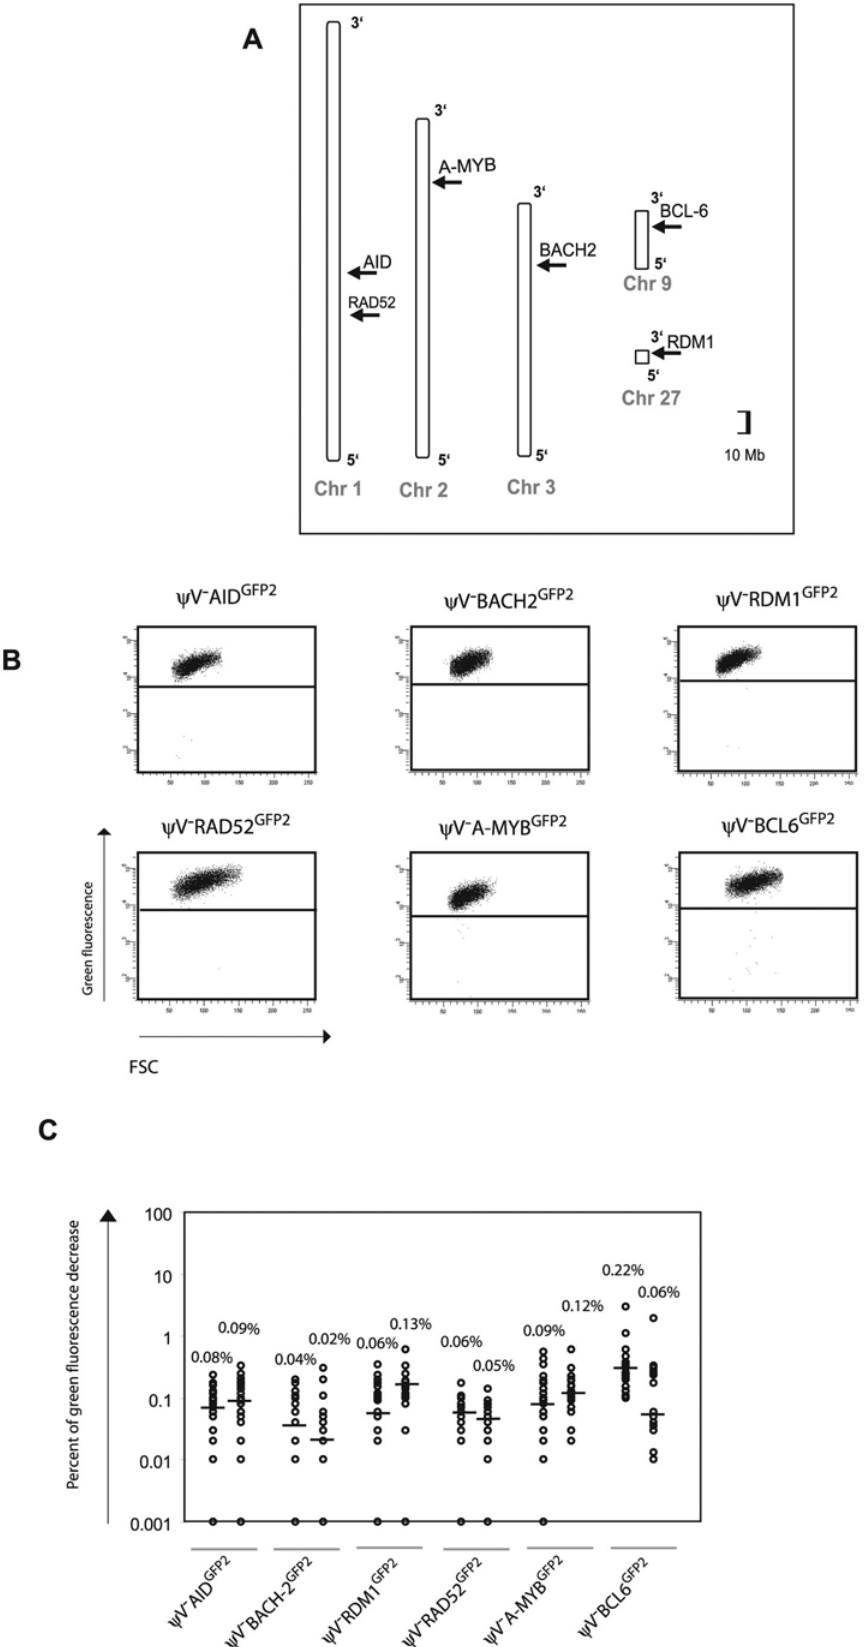
Figure 4. Insertions of the GFP2 reporter into non-Ig loci. (A) Chromosomal locations of the GFP2 insertions. (B) FACS analysis of primary transfectants. (C) Fluctuation analysis of subclones. doi:10.1371/journal.pgen.1000332.g004 PLoS Genetics | www.plosgenetics.org